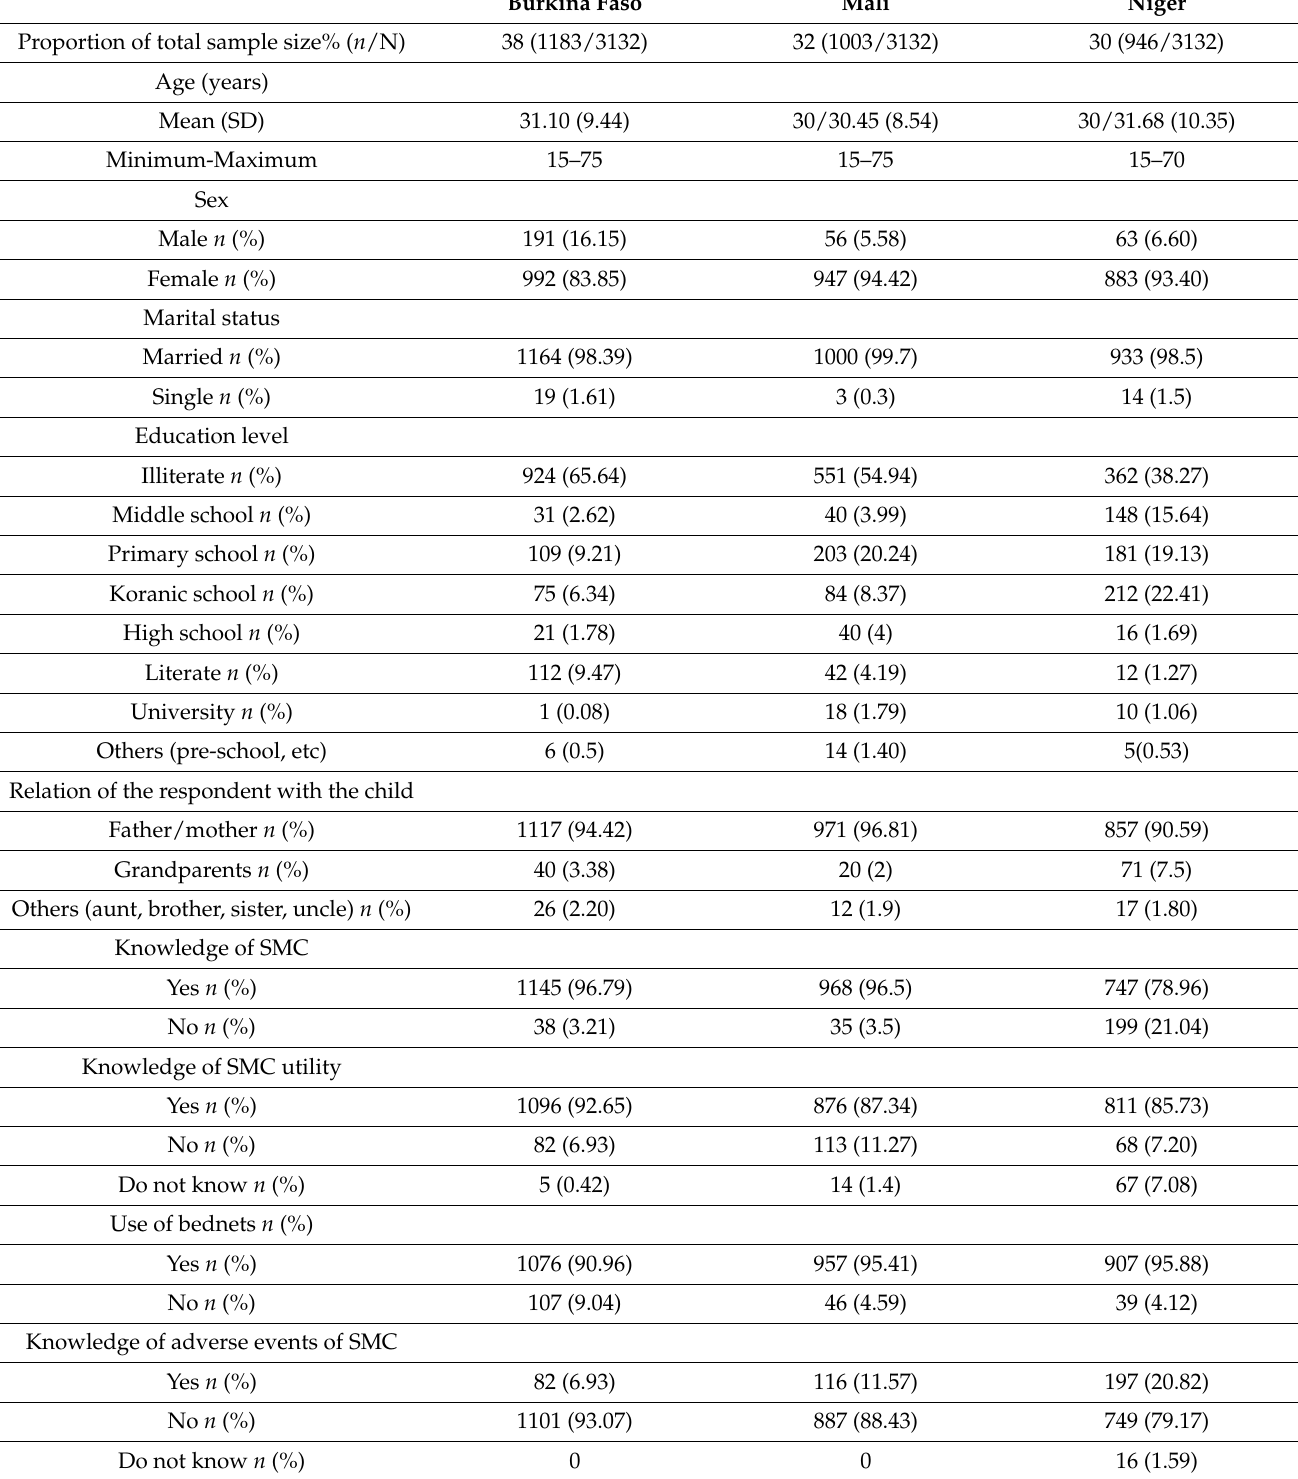
Table 1. Baseline characteristics of the survey’s